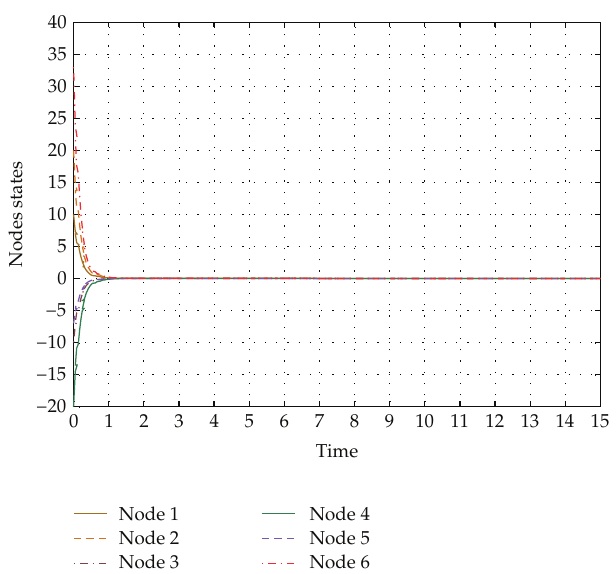
Figure 4: Node state trajectory of constant data acquisition